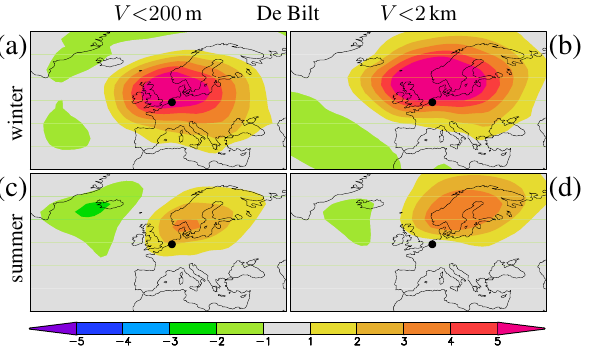
Fig. 7. As Fig. 6 but for Z¨urich Airport.